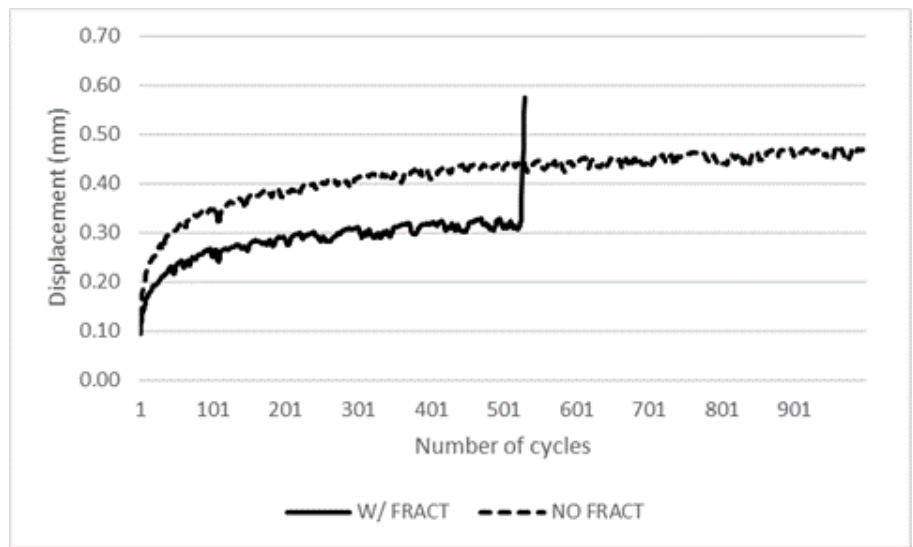
Figure 9. Pin displacement vs. number of cycles for cross-ply plates.